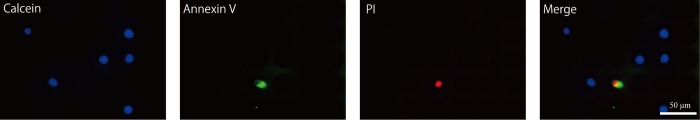
Viability and apoptosis assay.Annexin V (green) stains apoptotic cell, PI (red) stains dead cell and Calcein (blue) stains viable cells. Merged image identify both apoptotic and dead cell (green+red). Images of cells trapped in the microwells after 6 hours of incubation.